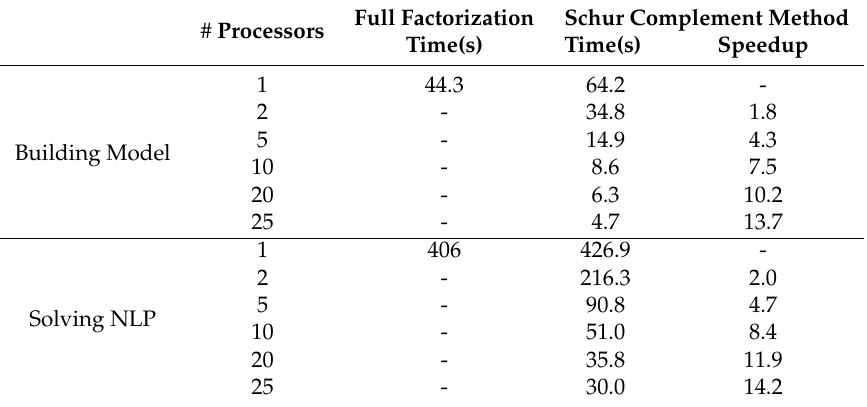
Table 3. The solution time of solving a robust optimization problem with 100 optimization